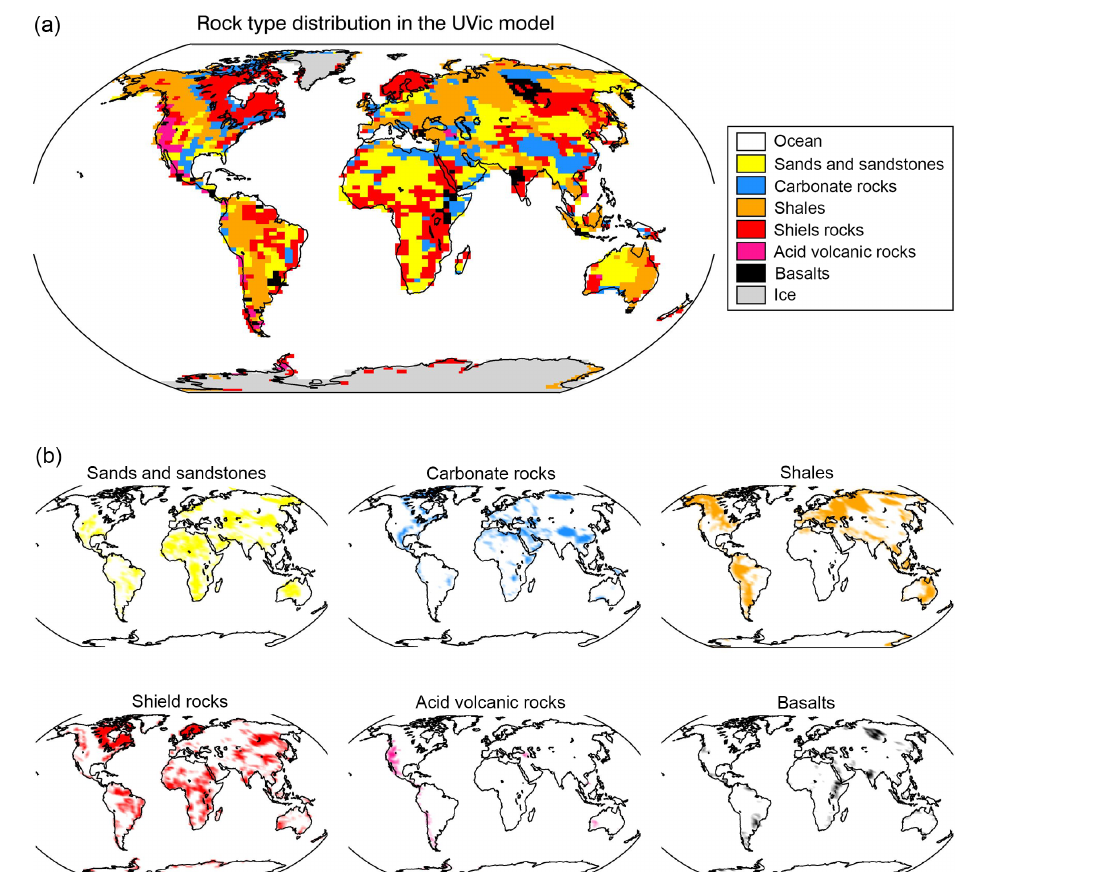
Figure 1. Distribution of the six major rock types for the present day. Presented here are (a) the source data from GEM-CO 2 (Amiotte Suchet et al., 2003), adapted to the resolution of UVic model, displaying only the dominant lithology in each grid cell, and (b) the interpolated rock type fraction in each grid cell. For the latter, the data are shown ranging from 0 (white) to 1 (full color).